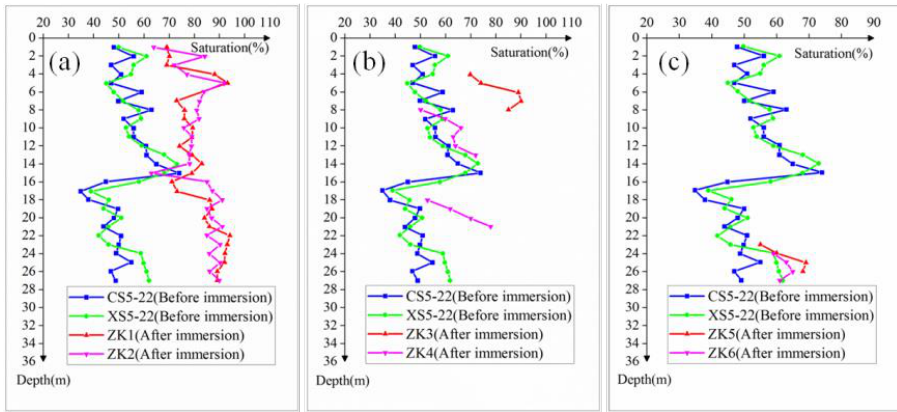
Figure 16. Saturation change, ( a ) saturation change of ZK1, ZK2, ( b ) saturation change of ZK3, ZK4, and ( c ) saturation change of ZK5, ZK6.